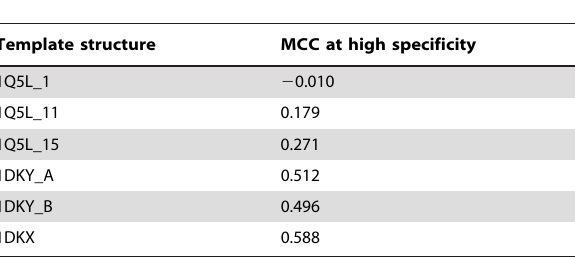
Table 1. Matthews correlation coefficient of a structure- based prediction in the high specificity area (90–100%) for different DnaK starting template structures.